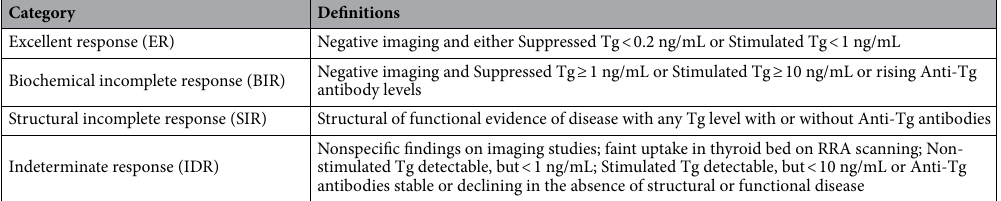
Table 1. Clinical implications of response to therapy reclassification in patients with differentiated thyroid cancer treated with total thyroidectomy and radioiodine remnant